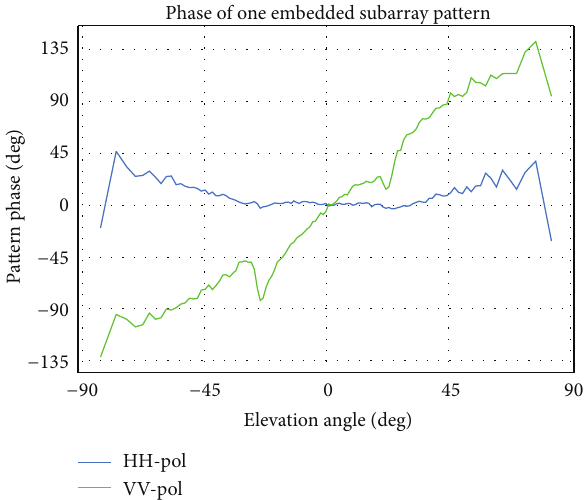
Figure 3: Phase deviation between HH and VV polarization for one subarray.